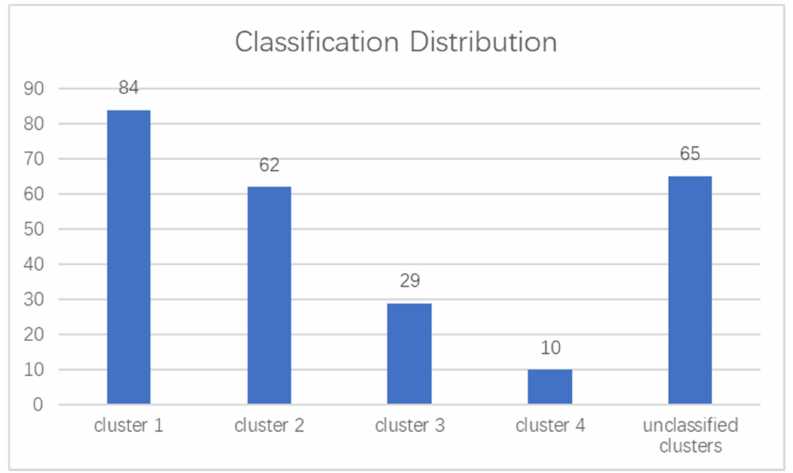
Figure 6. Research domains classification of the